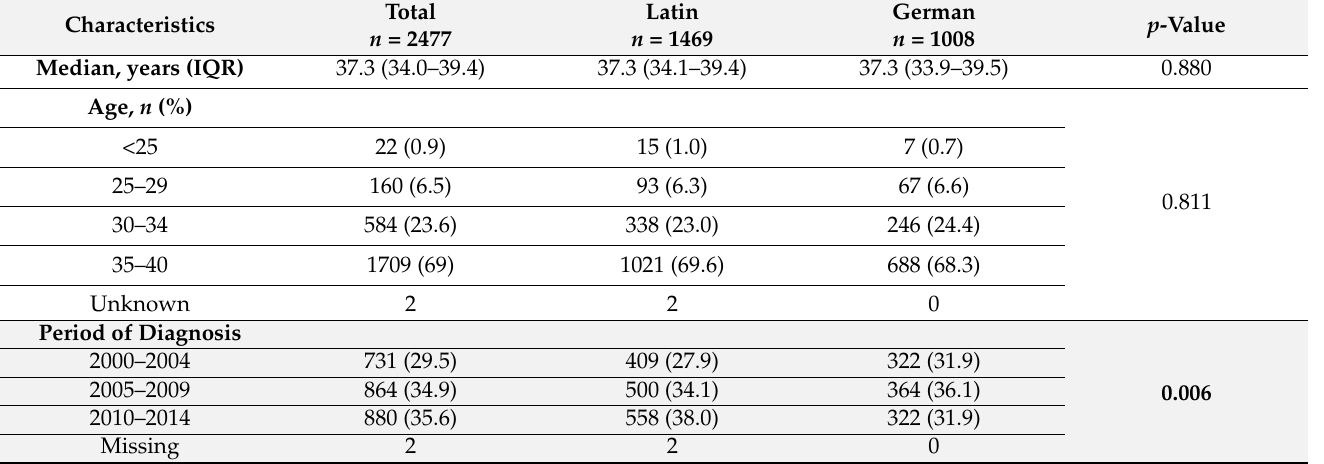
Table 1. Clinicopathological characteristics of the study cohort, stratified by linguistic-geographic region. Characteristics